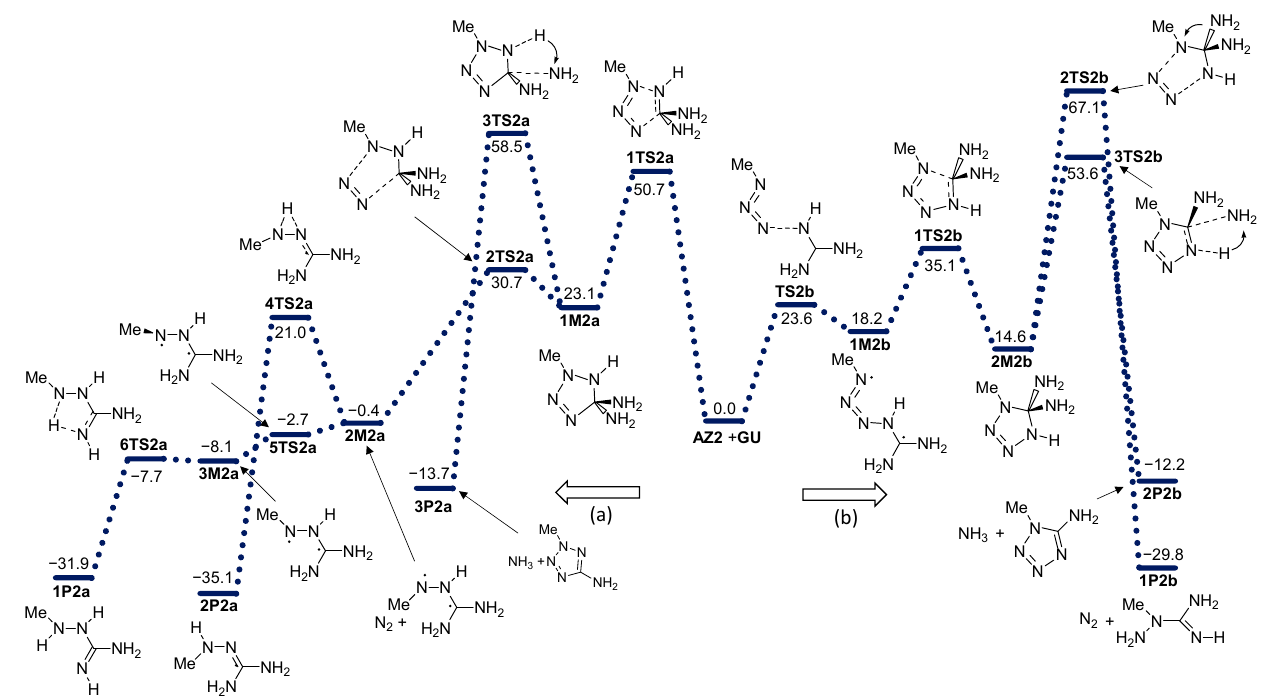
Figure 4. Energy profile for the addition of azide AZ2 with guanidine GU . Energies relative to reactants are given in kcal mol − 1 . ( a ) and ( b ) denote two modes of azide addition to GU